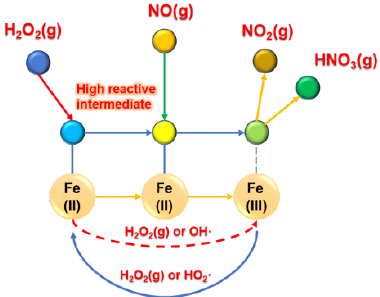
Figure 5. Mechanism of NO removal using Fe 2 O 3 -based Fenton-like oxidation system. Modified from [60] with permission from Elsevier, Copyright 2019.